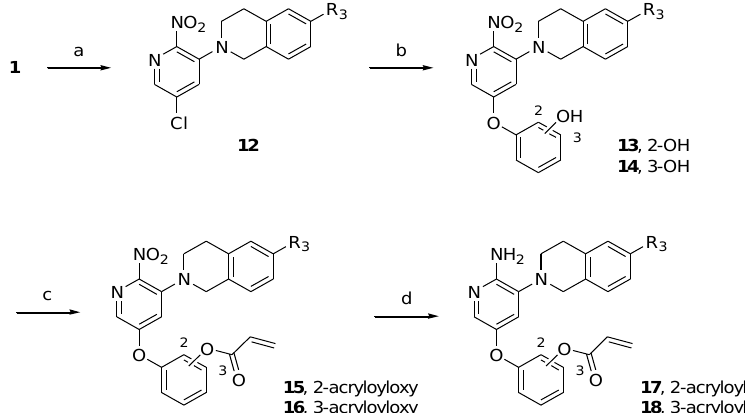
Scheme 3. Synthesis of tetrahydroisoquinoline-linked aminopyridine derivatives. Reagents